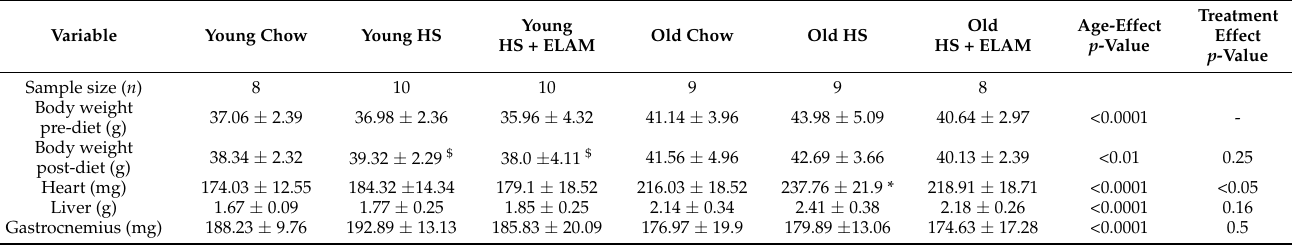
Figure 2. Differences in food intake ( A ), changes in body weight ( B ), and non-fasted serum glucose, insulin, and serum amyloid A (SAA) ( C – E ) between young adult and old adult male CB6F1 mice consuming regular chow or HS diet, treated with or without elamipretide (ELAM). Food intake was recorded per cage housing both saline and ELAM–treated groups. Two-way ANOVA was used to detect differences between age and treatment (Tx) groups. Significant effects are denoted by p –value and non–significant effects by “NS”. Data expressed as mean ± SD. Table 2. Mouse and tissue